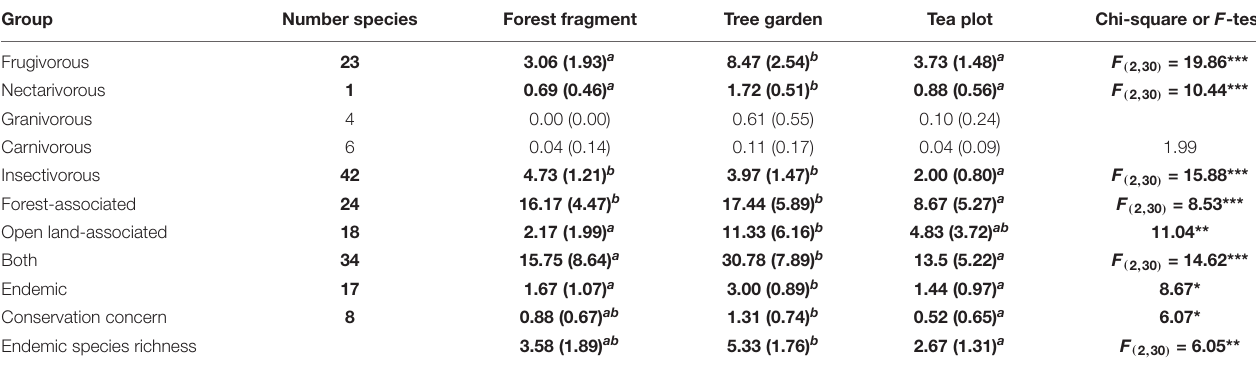
TABLE 1 | Mean abundance per point count visit of bird assemblage subsets. Group Number species Forest fragment Tree garden Tea plot Chi-square or F -test